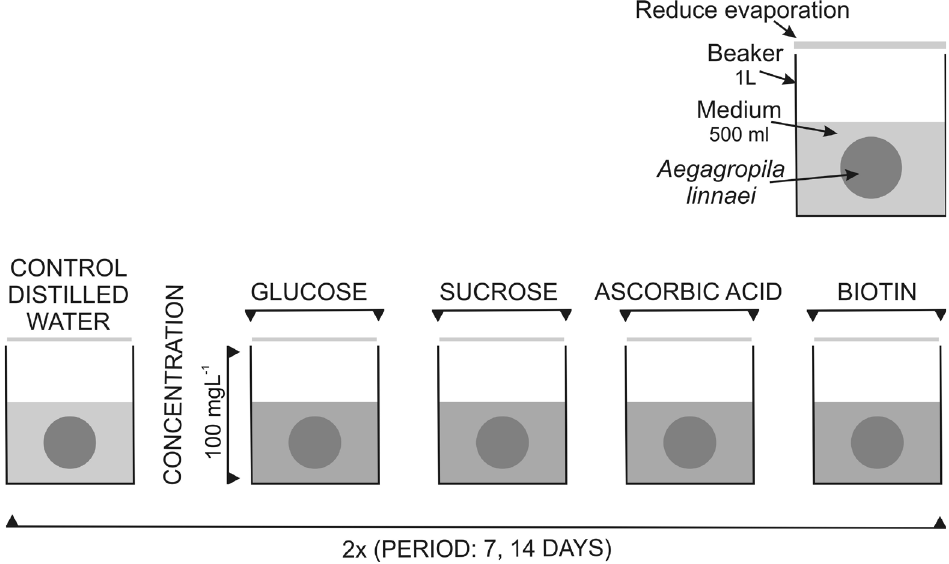
Figure 1: The laboratory